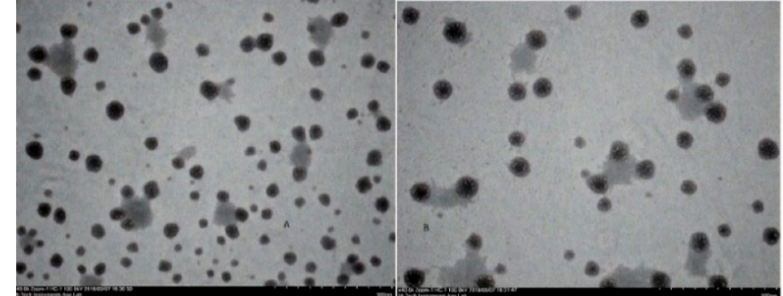
Figure 5. Transmission Electron Microscopy (TEM) images of ( A ) placebo chitosan nanoparticles and ( B ) rotigotine-loaded chitosan nanoparticles (Scare bar 500 nm).